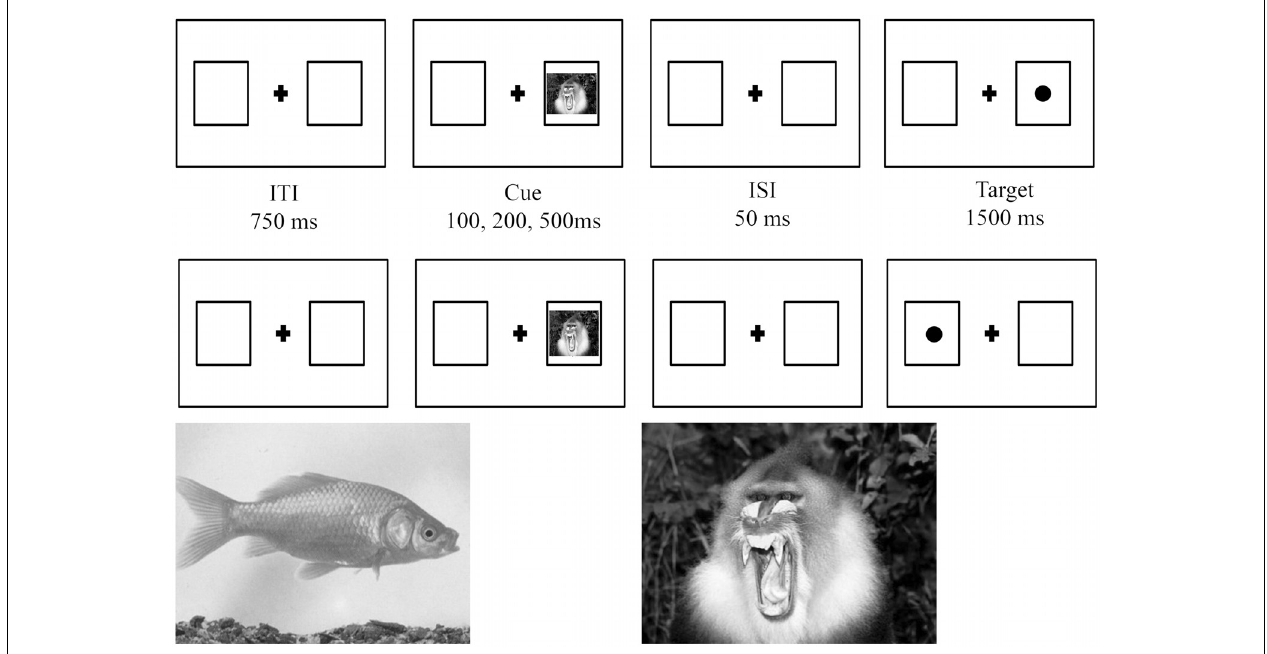
FIGURE 1 | Schematic overview of valid (first row) and invalid trials (middle row). Examples of non-treatening (left) or threatening (right) stimuli are depicted in the bottom row.